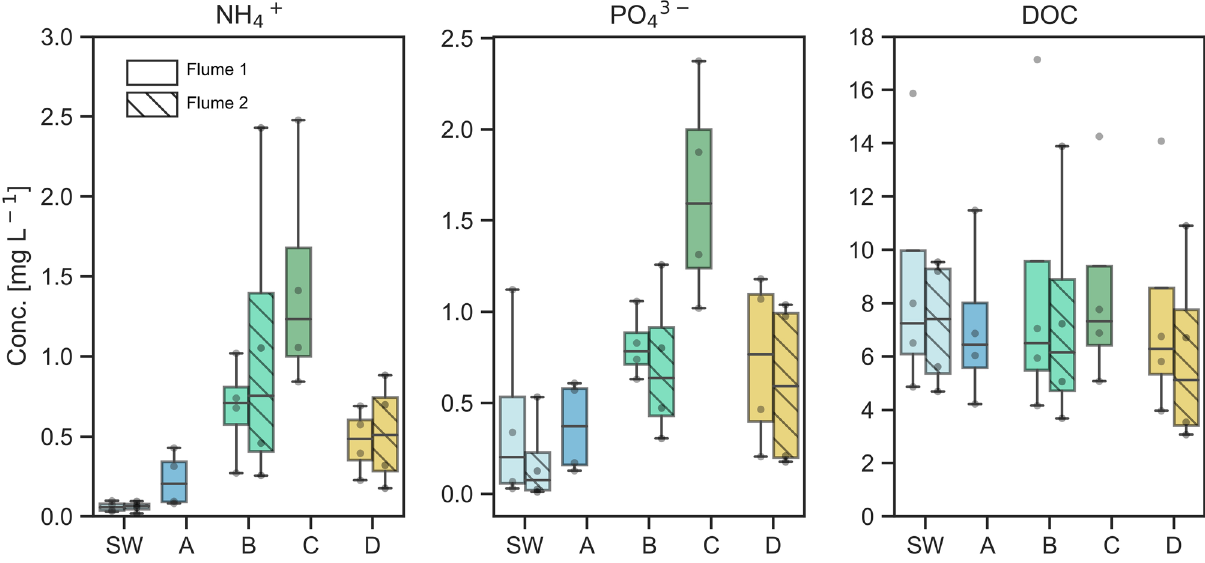
Figure 3. Boxplots of concentrations of NH 4 + , PO 4 3− and DOC in the SW, in Bedform 1 (Samplers A, B, and C) and Bedform 2 (Sampler D) of Flumes 1 and 2 aggregated over the PW sampling days 0, 21, 42 and 78 (n =